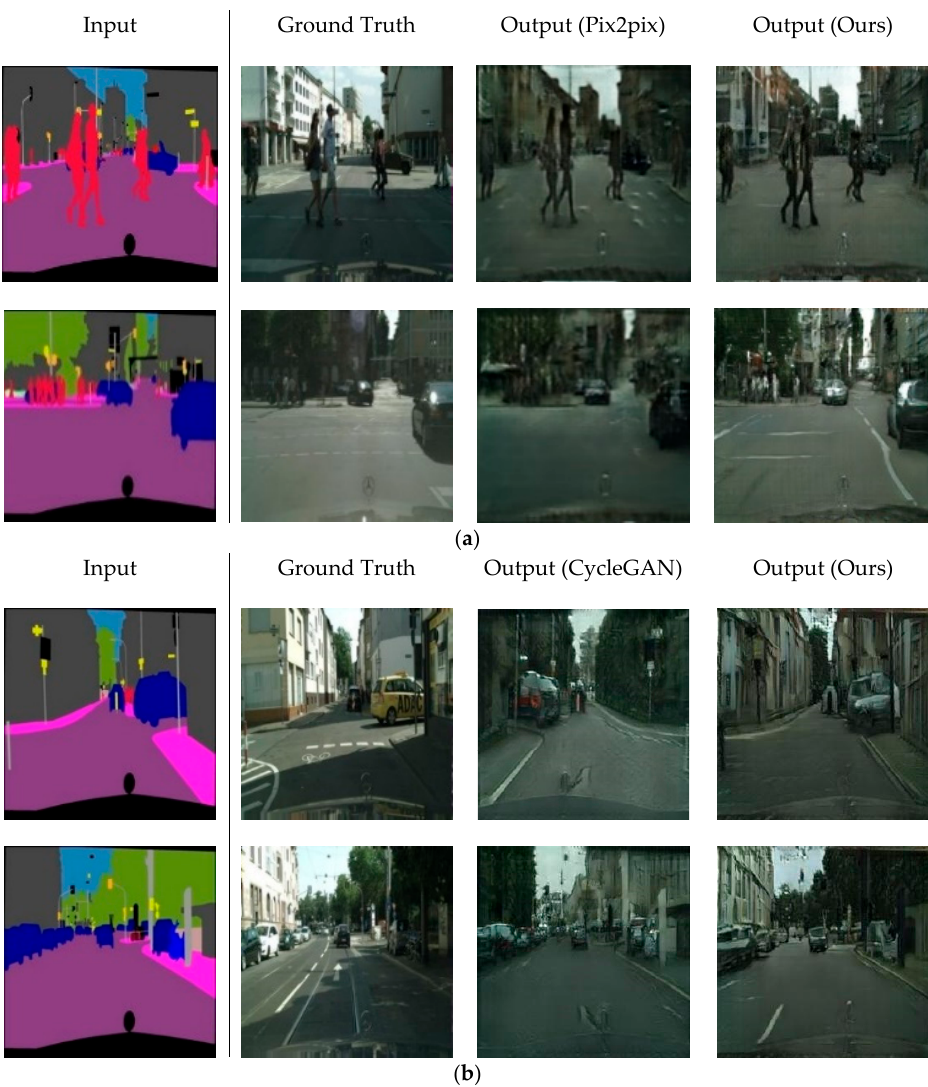
Figure 1. Low-quality photographs showing unstable flaws in the translated images of Pix2pix ( a ) and CycleGAN ( b ). From left to right: input, ground truth, output (baseline) and output (ours). ( a ) In the results of label → photo by Pix2pix, various notable noises and blurs are observed, which reduces the quality of the translated pictures. ( b ) In the translated pictures of label → photo by CycleGAN, some building segments are painted with tree pictures and vice versa, while our results show translating each segment accurately.